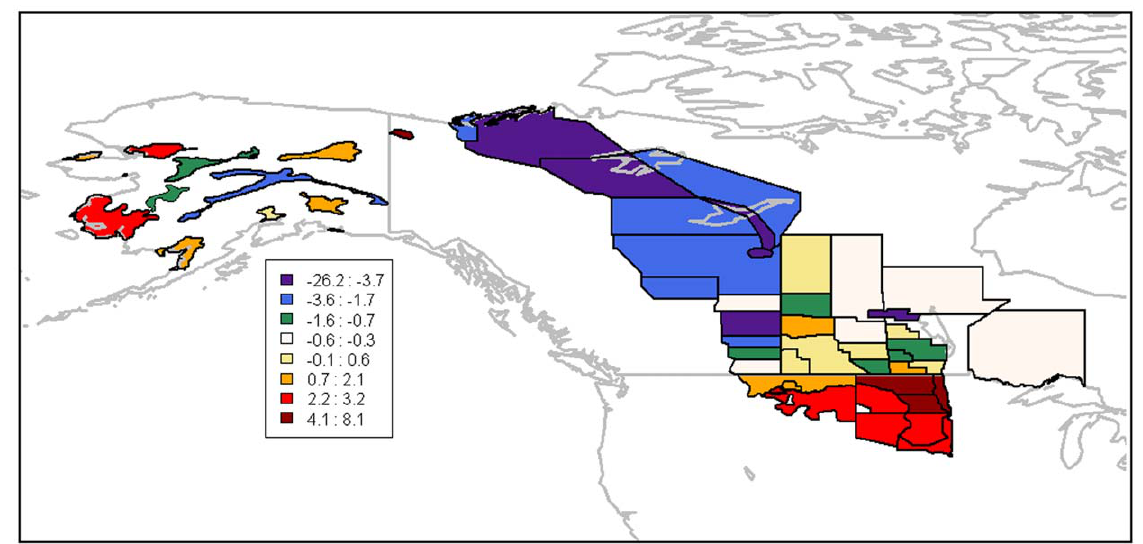
Figure 1. Changes in counted breeding pair abundance since 1957 based on posterior distributions for the b 1, j coefficients. Negative numbers indicate pairs lost and positive numbers indicate pairs gained. Note that not all differences are estimated to be statistically different from zero.